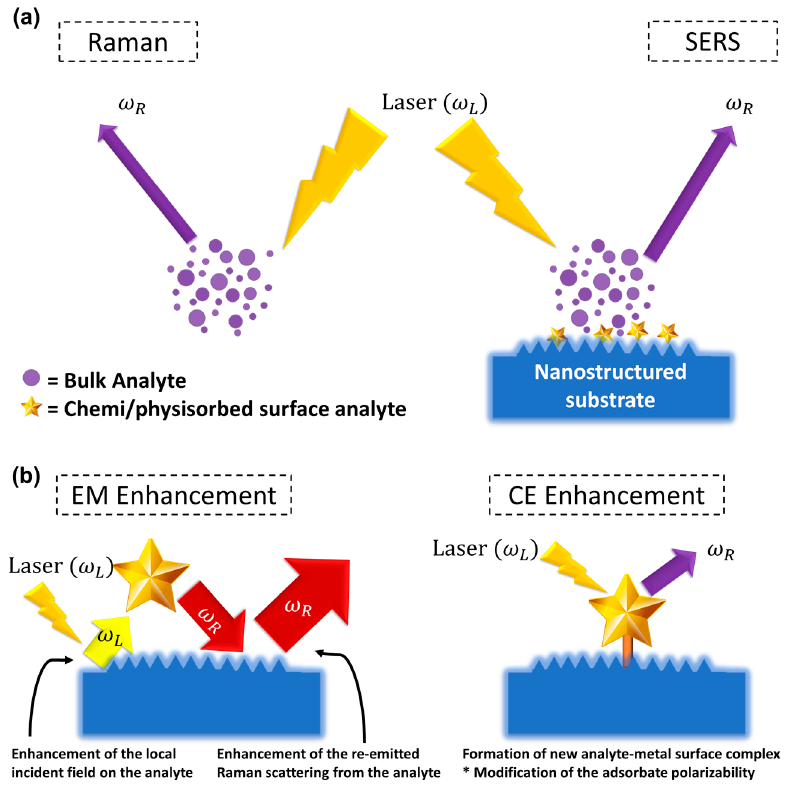
Figure 2. ( a ) A schematic comparison of the Raman and SERS phenomena. ( b ) SERS electromagnetic and chemical enhancements’ schematic.